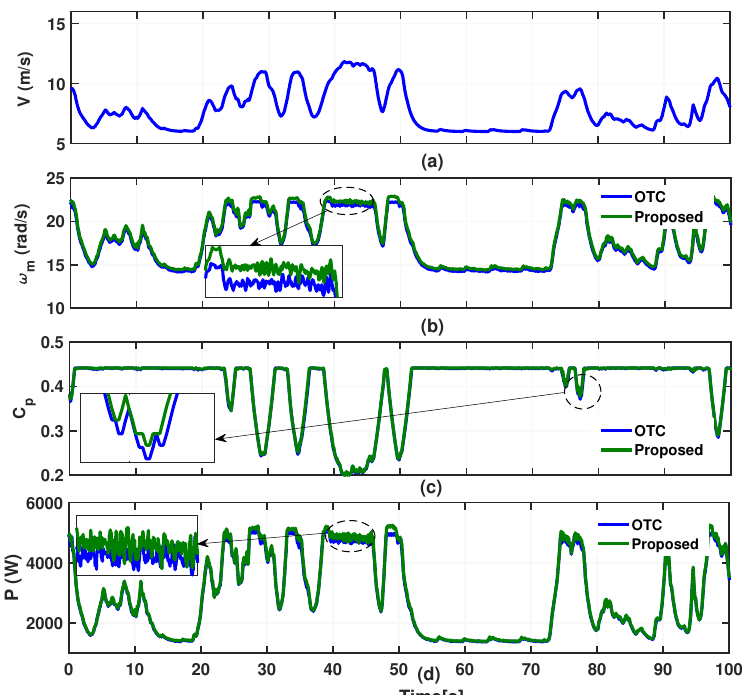
Figure 17. Experimental results for real wind speed: ( a ) Real wind speed. ( b ) Rotor speed. ( c ) Power coefficient. ( d ) Output